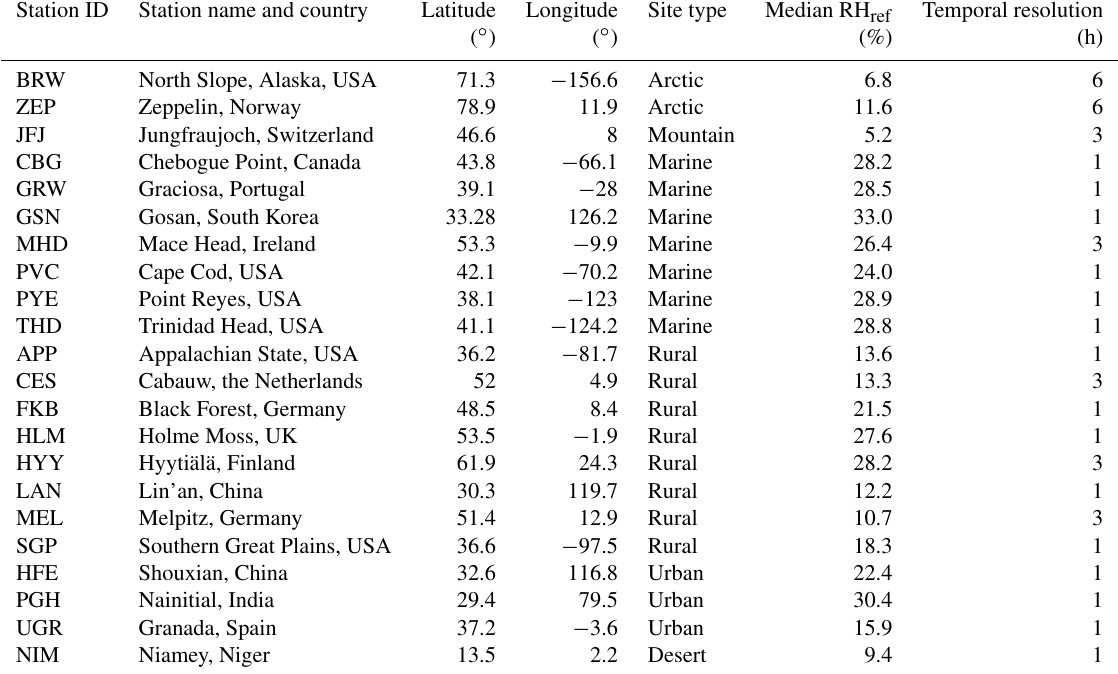
Table 1. General site information. The median RH ref refers to the relative humidity inside the (dry) reference nephelometer, while the temporal resolution refers to measured values of f (RH). More details and references on the sites can be found in Burgos et al. (2019). Station